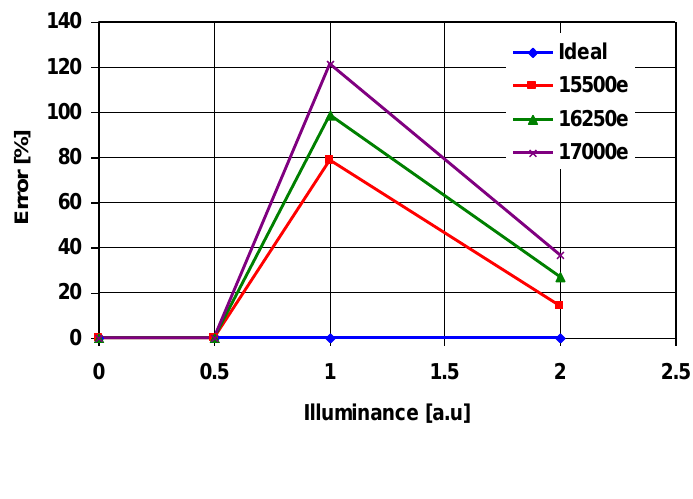
Figure 13. Non-linearity in high illumination region (error in